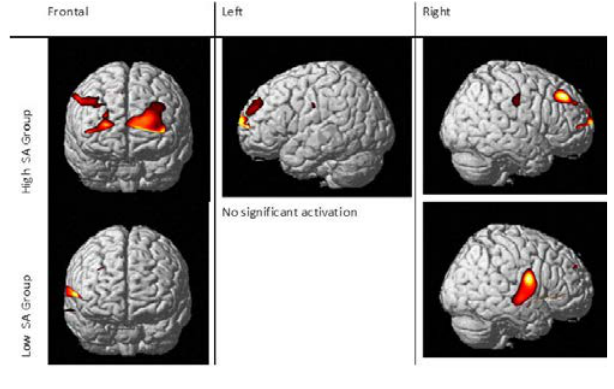
Figure 1.3.1: Comparison of Significant Brain Activation between High and Low SA Groups The brain activation occurring in the frontal